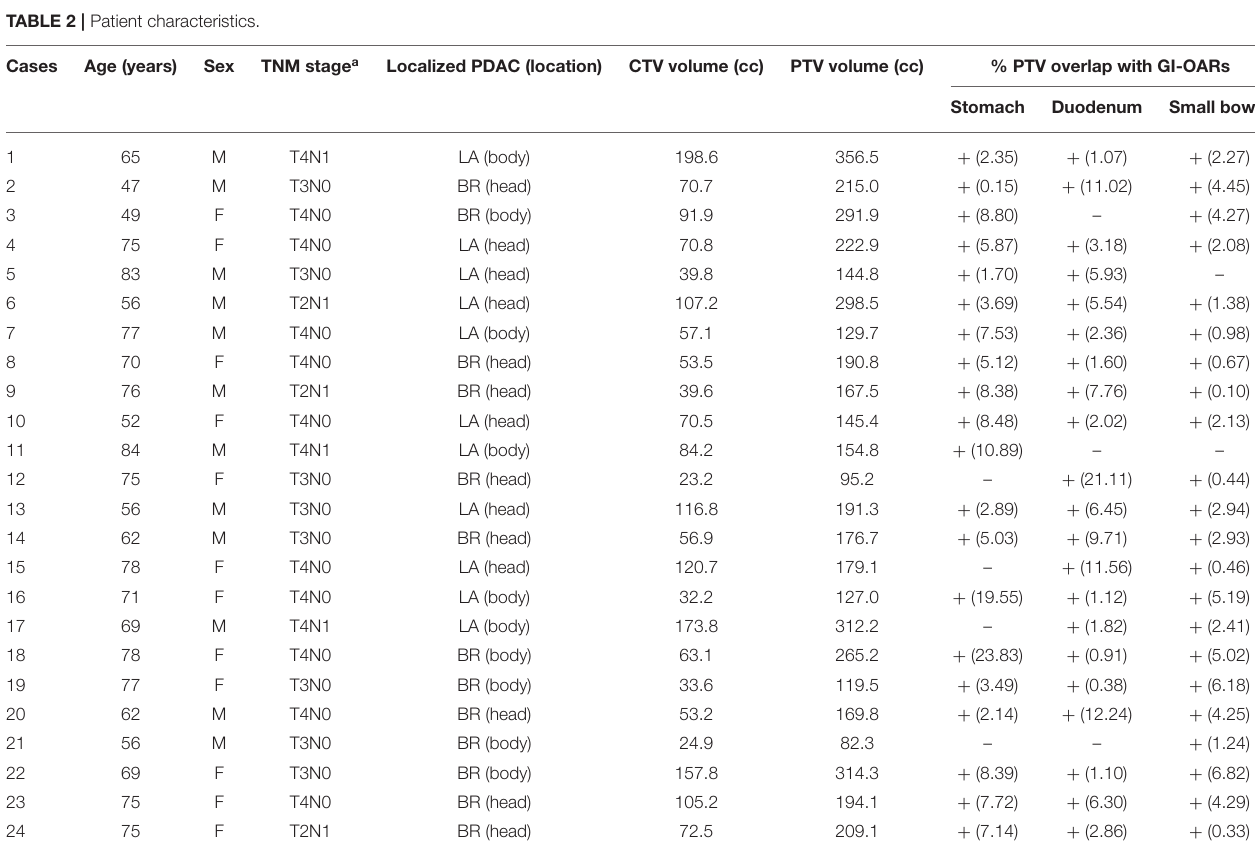
TABLE 2 | Patient